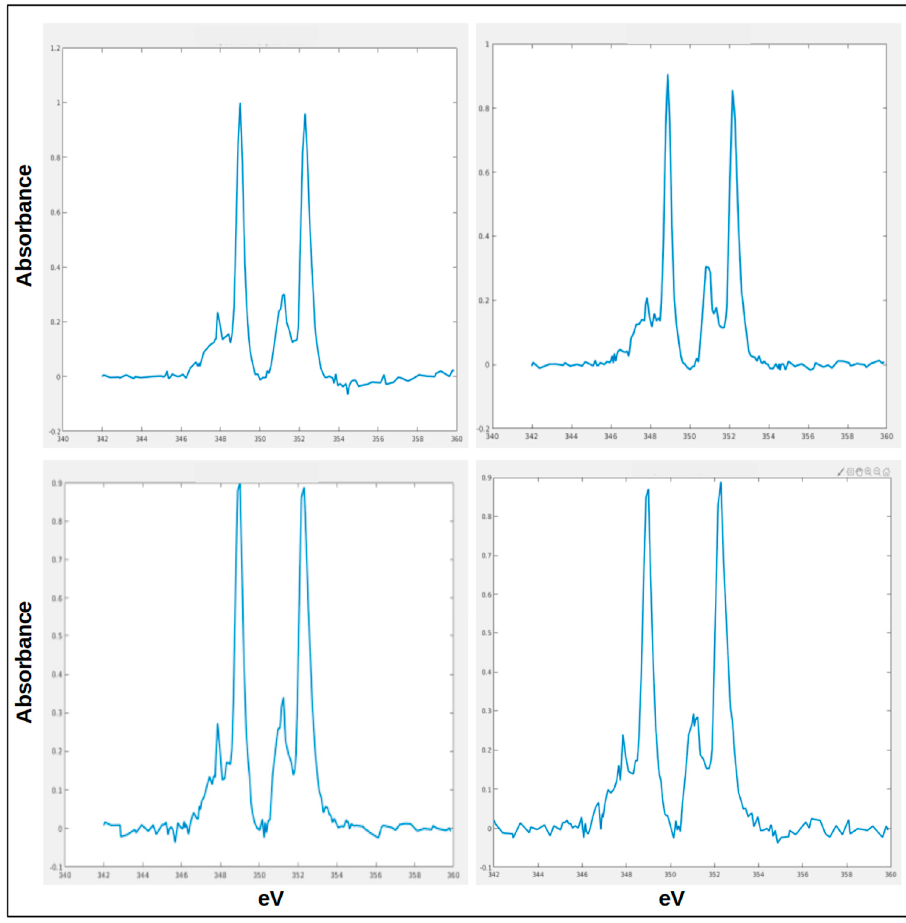
Figure 6. Spectra from depositions in bMSC-4D that show features similar to HA reference spectrum. These four spectra are the only spectra found in bMSC-4D which cannot be attributed to calcite. Despite the low signal-to-noise ratio, they show indeed features similar to the ones observed in HA spectra from bMSC-10D.